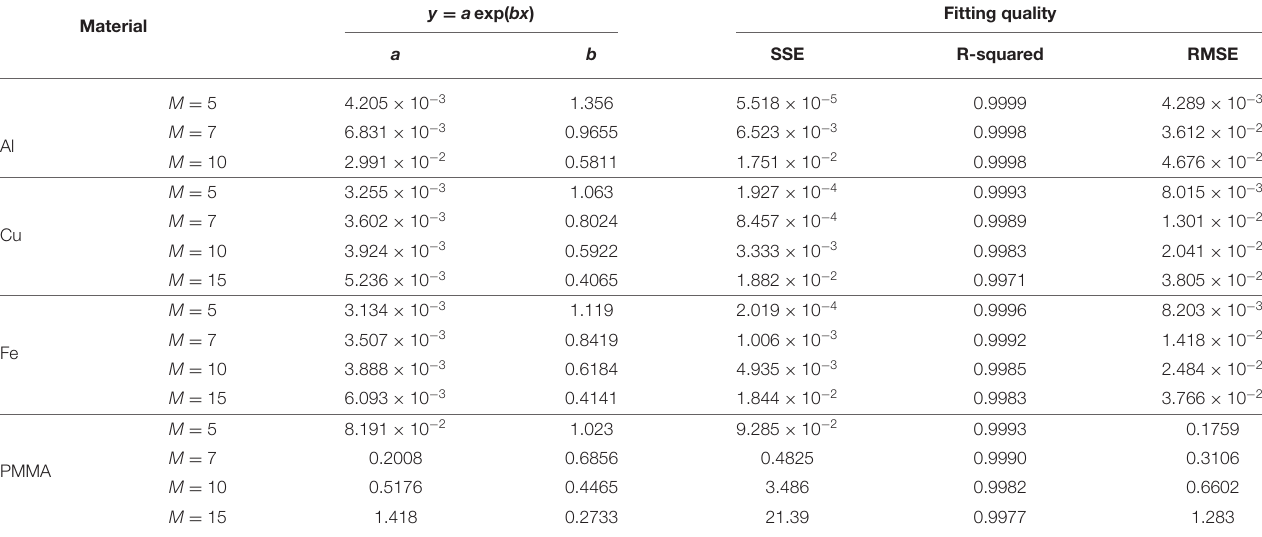
TABLE 2 | Fitting results of the optimal thicknesses curves in Figures 3 , 5 – 7 , respectively.